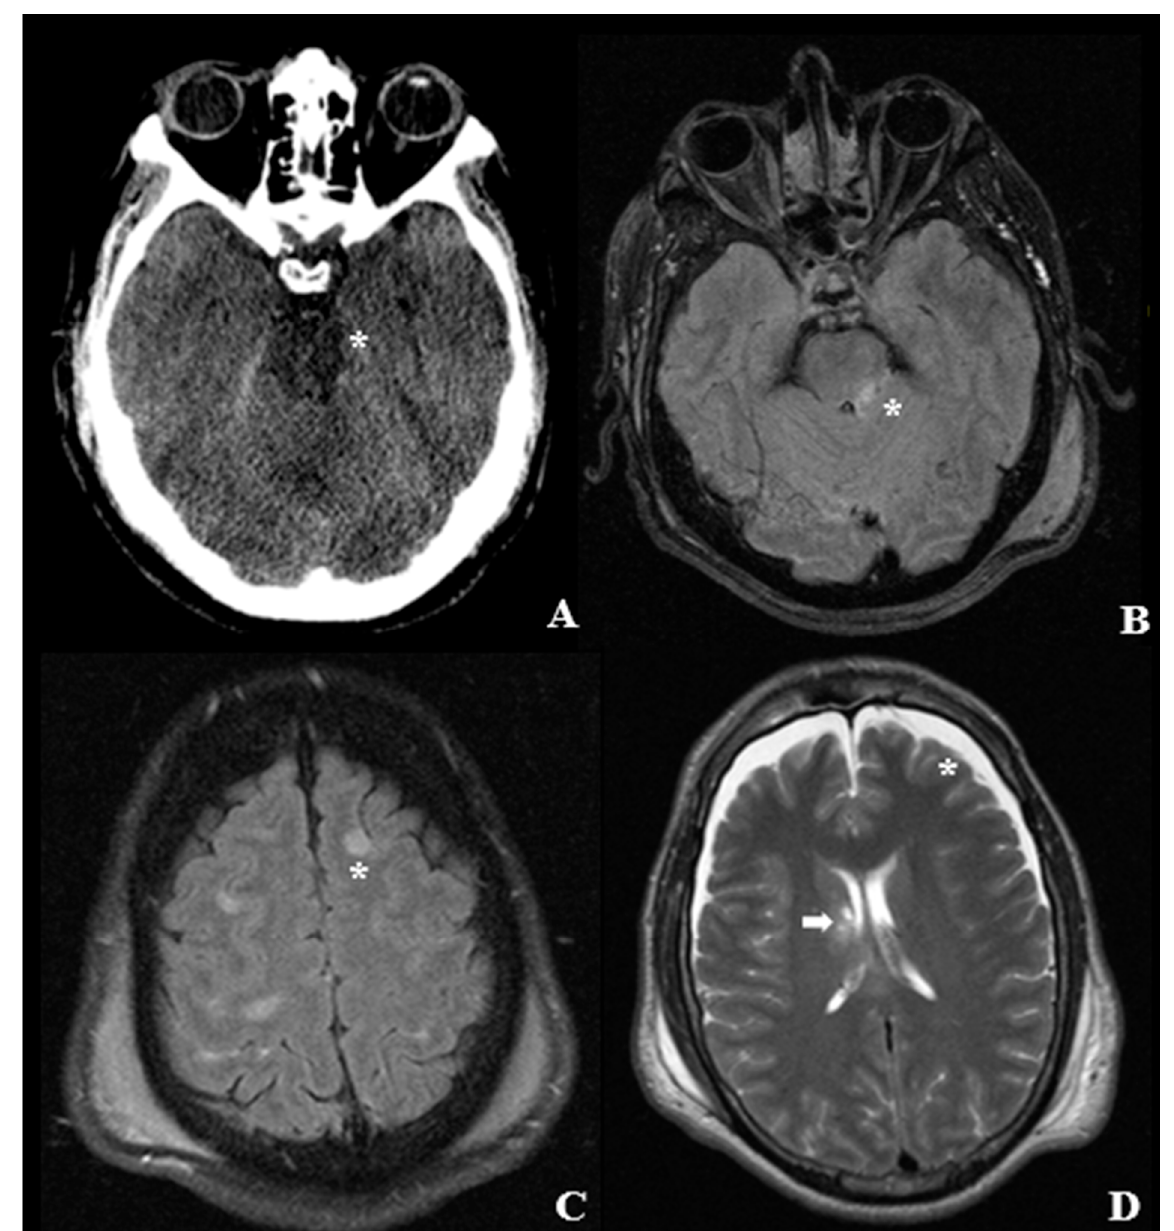
Figure 1. Radiological findings in a case of DAI—( A ) First computed tomography (CT) scan disclosing the absence of ambiens cistern and a slight hypodensity of the transition zone between mesencephalon and pons. ( B , C ) Flair sequence late MRI disclosing the diffuse involvement of the subcortical with matter and of the brachium pontis. ( D ) T2 weighted MRI scan disclosing the late atrophic changes of the supratentorial cerebrum with a bilateral subdural hygroma. The arrow highlights a neural injury at the transition between the body of the caudate nucleus and the internal capsule.